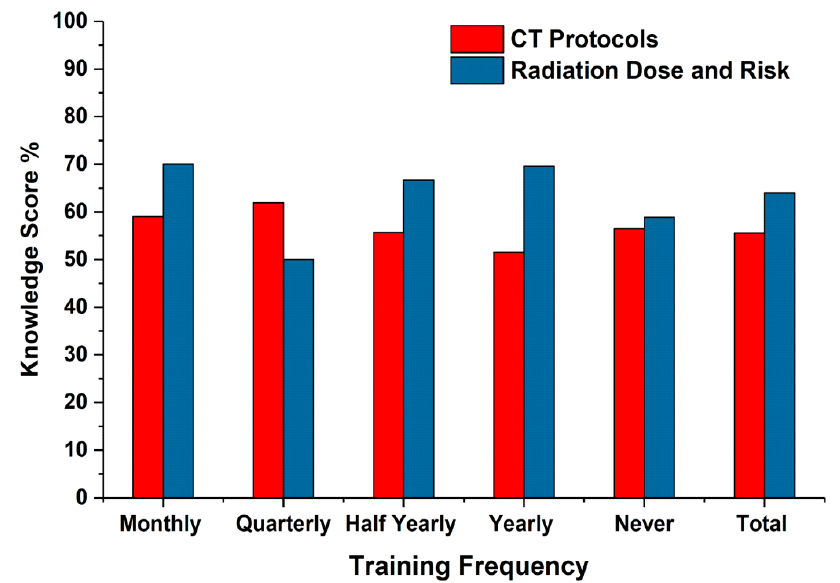
Figure 5. Comparison of participants’ knowledge of CT protocol and radiation dose based on training frequency.